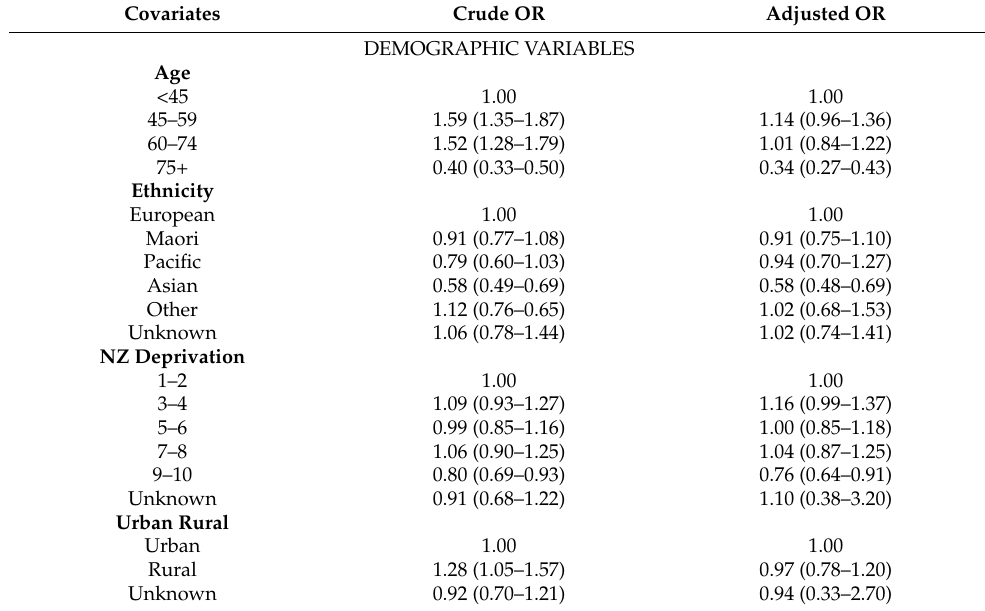
Table 1. Odds ratios (OR) from logistic regression across BCS + RT 1 vs. BCS 2 /MTX 3 /MTX + RT 4